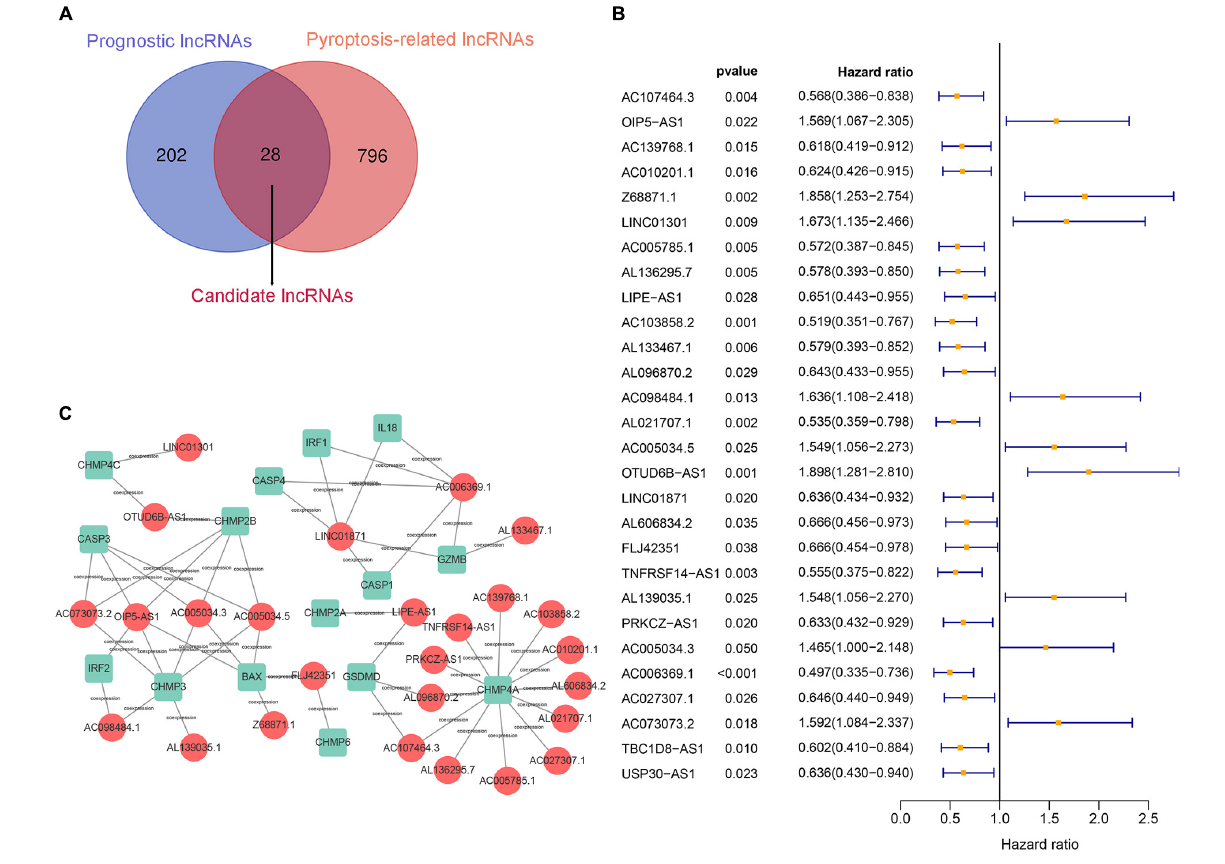
FIGURE 2 | Construction of a prognostic pyroptosis-associated lncRNA signature. (A) Identify the overlap of lncRNAs between prognostic lncRNAs and pyroptosis-associated lncRNAs through the Venn diagram. (B) Results of the univariate Cox regression analysis of prognostic pyroptosis-associated lncRNAs in OS of BC patients. (C) LncRNA–mRNA coexpression network of pyroptosis-associated lncRNAs and corresponding